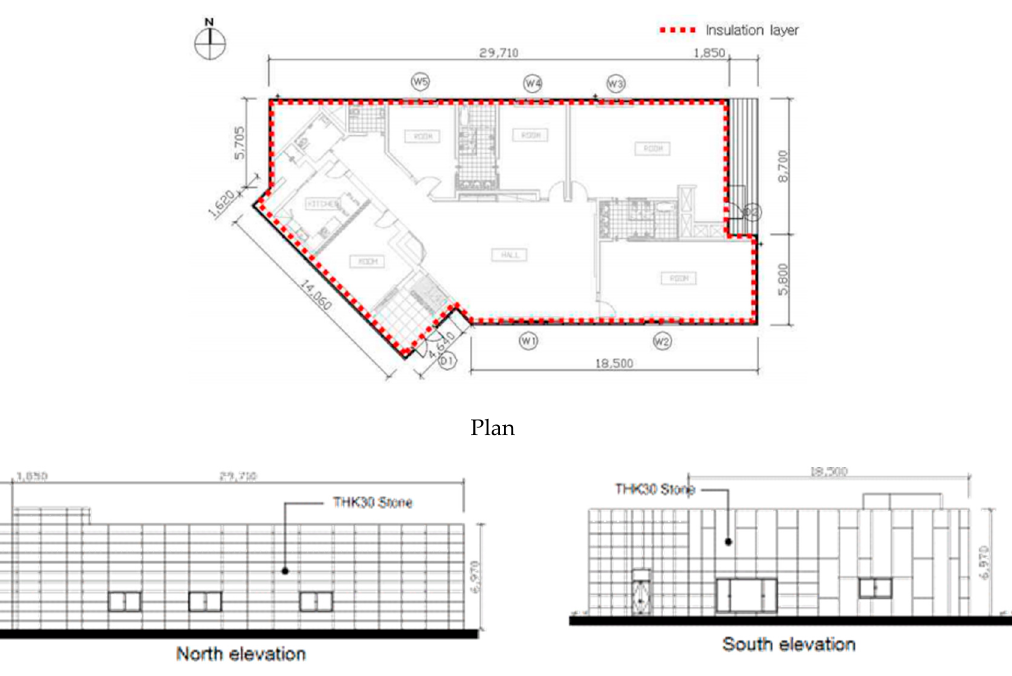
Figure 9. Plan and elevation of the example building . Table 5. U-values of the envelope.